Question: In a single sentence, describe what this figure presents.
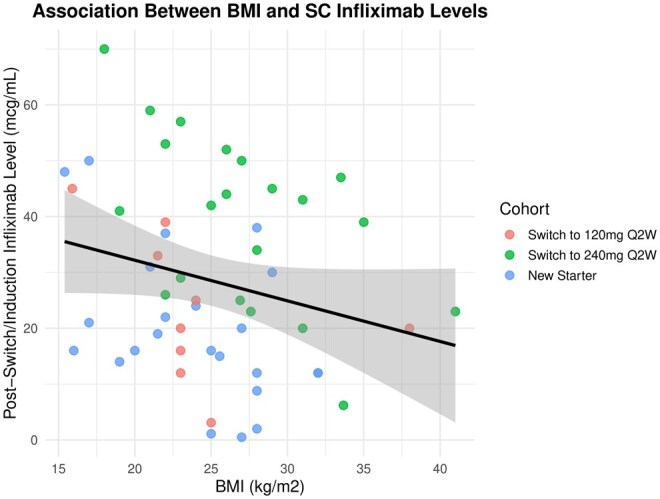
Answer: Correlation between body mass index (BMI) and infliximab trough levels. Scatter plot showing the relationship between BMI (kg/m 2 ) and post-treatment infliximab trough levels (µg/mL) across all patients. Each point represents an individual patient’s trough level and BMI. A linear regression line with 95% confidence interval is overlaid. Pearson correlation: r = −0.24, P = .082.